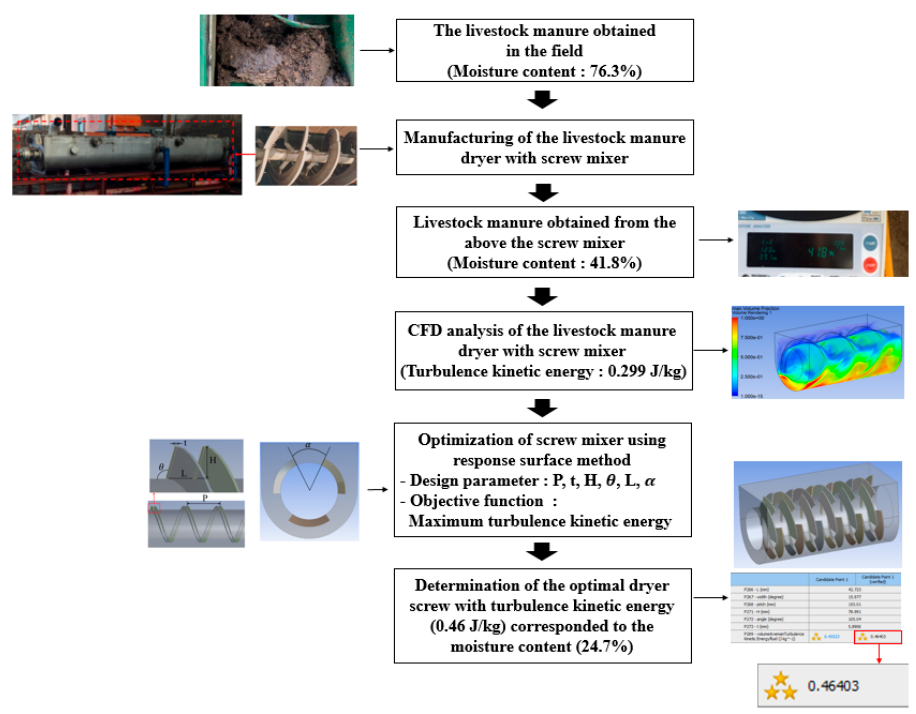
Figure 3. Design process of dryer screw for drying of livestock manure.